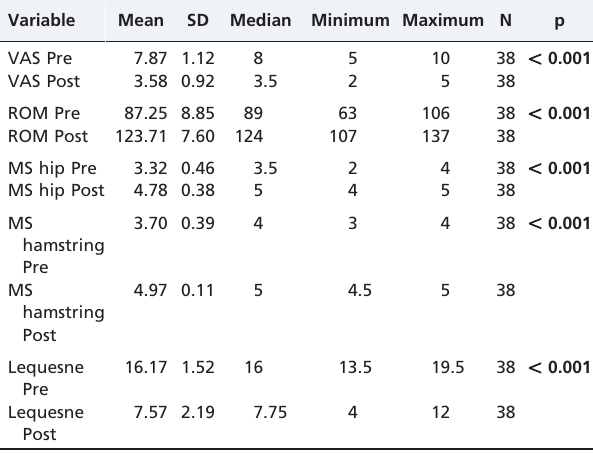
Table 2 - Pain (analyzed by the visual analogue scale, VAS), range of joint movement (ROM), strength (MS) and the result of the Lequesne evaluation for function presented as mean, standard deviation (SD), median, minimum, maximum, N and p values according to the moment of evaluation.